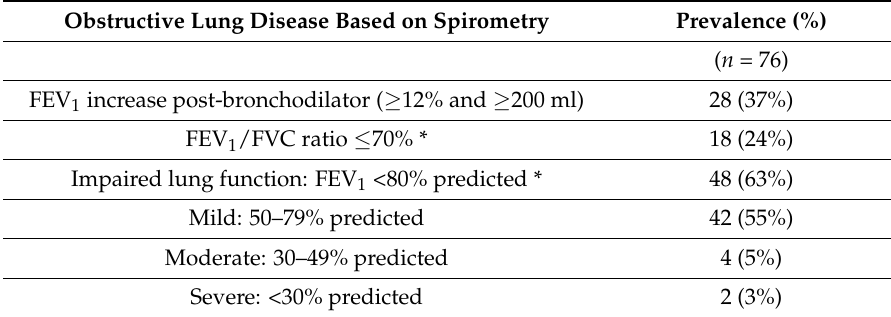
Table 2. Prevalence of obstructive lung disease among cases exposed to the sulphur stockpile fire incident. Obstructive Lung Disease Based on Spirometry Prevalence (%)